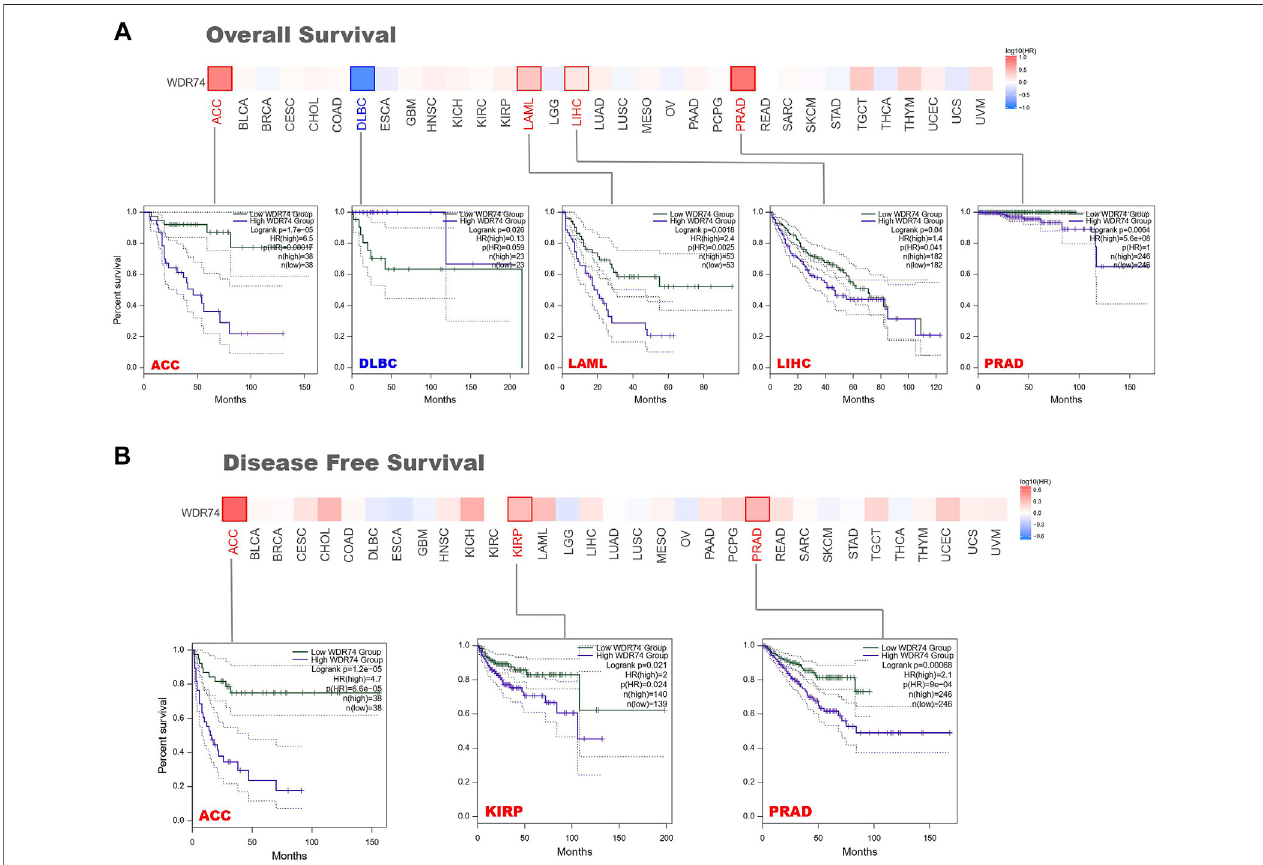
FIGURE2| SurvivalprognosisbetweengroupswithhighandlowWDR74expressionlevelswasobtainedonGEPIA2basedontheTCGAproject. (A) TheKaplan- MeieranalysisofoverallsurvivalwithWDR74 expression intheACC,DLBC, LAML,LIHCandPRAD. (B) TheKaplan – Meieranalysisofdisease-freesurvivalwithWDR74 expression in the ACC, KIRP and